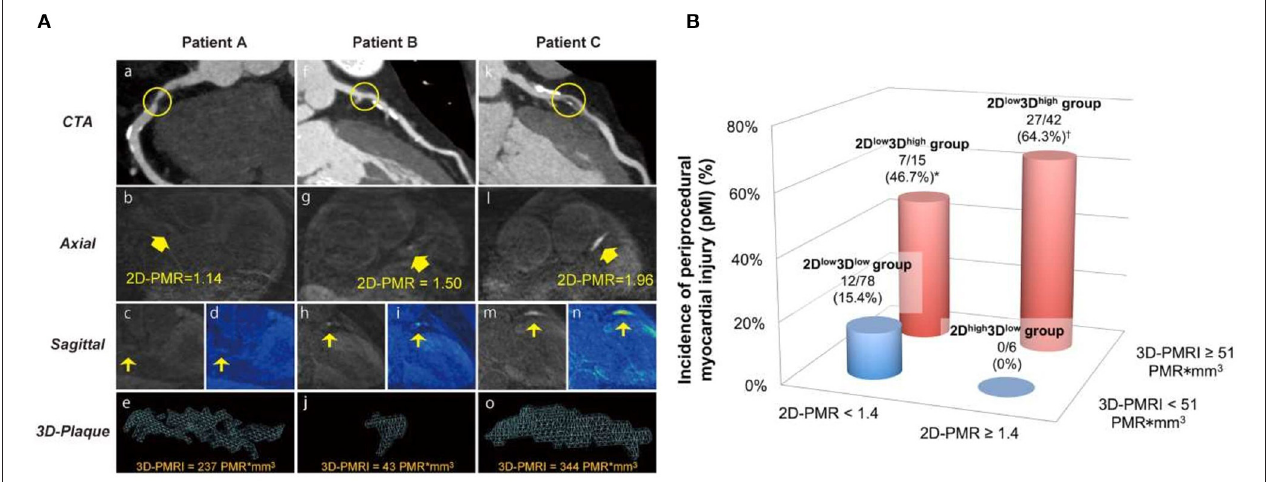
FIGURE 12 | (A) Representative 2-dimensional and 3-dimensional plaque assessment on T1-weighted imaging. Coronary plaques with 2D low 3D high in the proximal right coronary artery (2D-PMR, 1.14; 3Di-PMR, 237 PMR*mm 3 ; Patient A: a–e), 2D high 3D low in the proximal left anterior descending artery (LAD) (2D-PMR, 1.50; 3Di-PMR, 43 PMR*mm 3 ; Patient B: f–j), and 2D high 3D high in the proximal LAD (2D-PMR, 1.96; 3Di-PMR, 344 PMR*mm 3 ; Patient C: k–o). Computed tomography angiography (CTA) images (a, f, k), and axial images (b, g, l), sagittal images (c, h, m), colour maps (d, I, n), and 3D region of interests (3D plaque: e, j, n) on T1w images are shown. Yellow circles indicate percutaneous coronary intervention target lesion sites on CTA. Yellow arrows indicate lesions on T1w imaging corresponding to a lesion on angiography that underwent intervention. (B) Incidence of periprocedural myocardial injury (pMI) based on 3Di-PMR and 2D-PMR cutoff values. The red and blue bars represent patients with 3Di-PMR ≥ 51 PMR*mm 3 and < 51 PMR*mm 3 , respectively. P < 0.001 based on the chi-squared test. * P = 0.006 vs. 2D high 3D low group. † P < 0.001 vs. 2D low 3D low group, and P = 0.003 vs. 2D high 3D low group. Adapted with permission from Hosoda et al. (90).